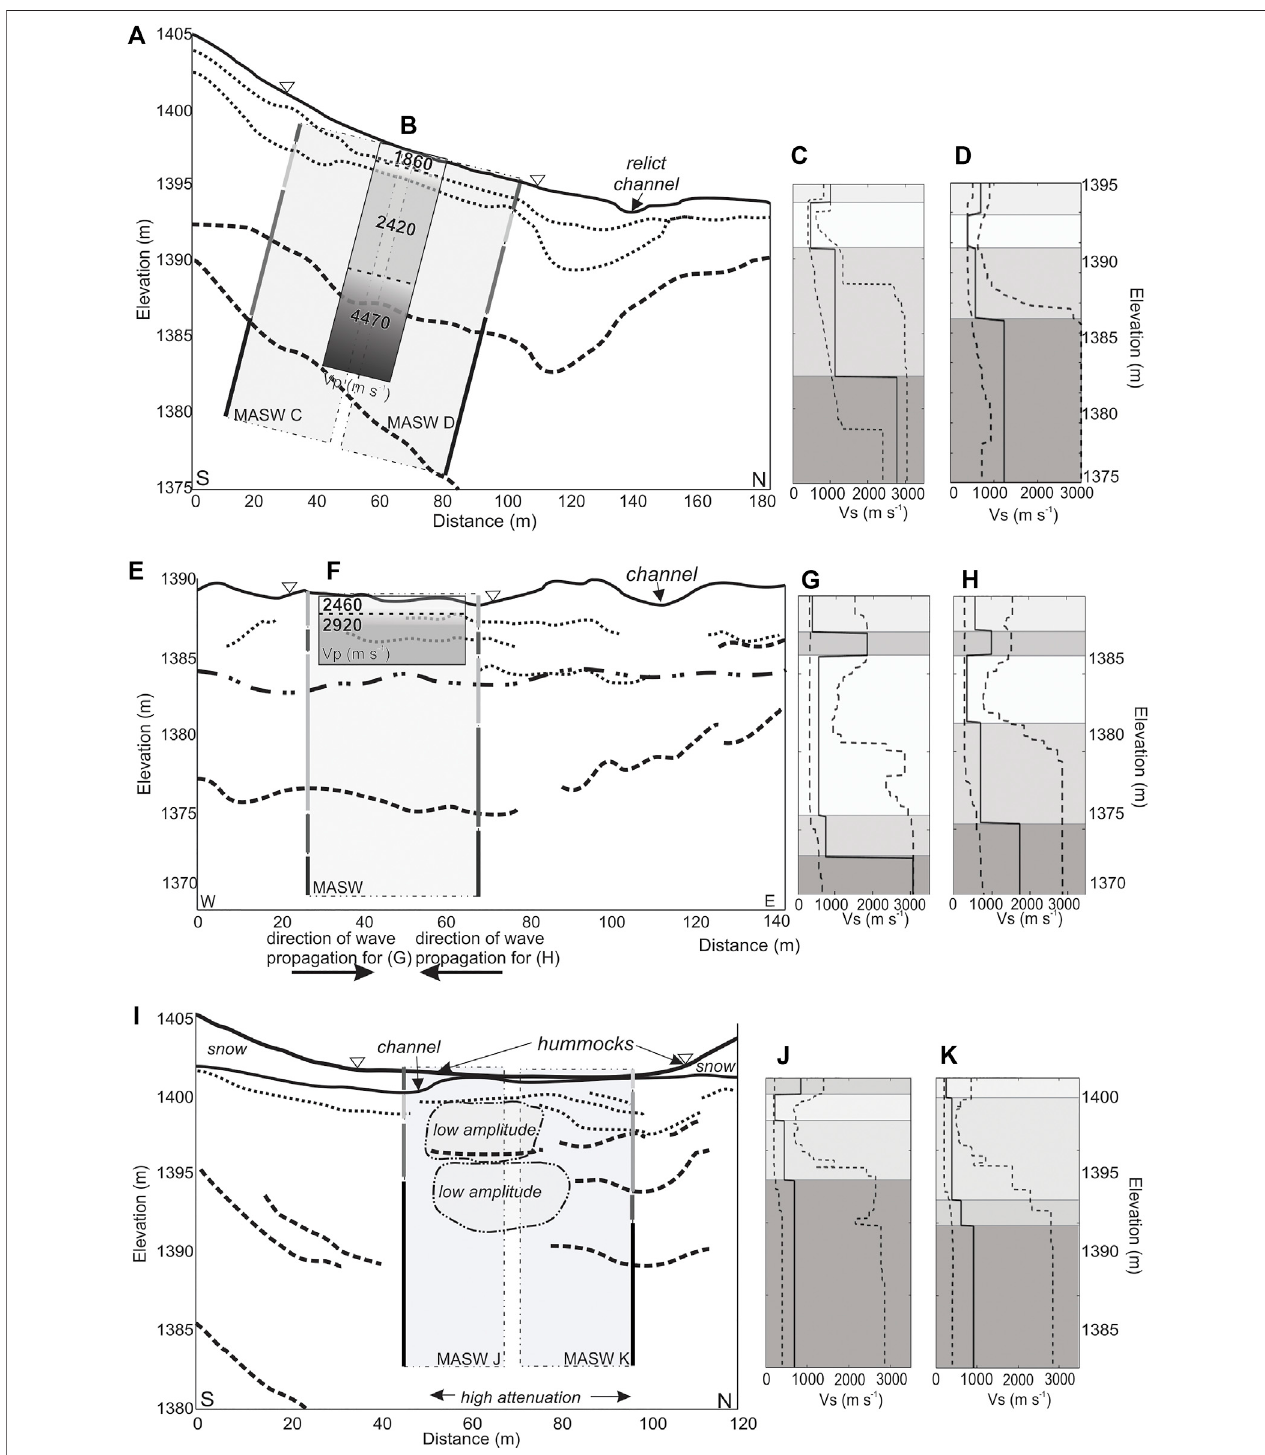
FIGURE 11 | Summary diagrams of the subsurface conditions beneath the seismic spread locations at the Lateral Moraine Site (A – D) , the Terminal Moraine Site (E – H) ,and the Hummocky Site (I – K) .(A), (E) &(I) Key features identi fi edfrom GPRradargrams. Dotted lines depict dominantre fl ections from 100 MHz pro fi les ( Figures 4B , 6B , 9B ),dashedlinesfrom25 MHzpro fi les( Figures4D , 6D , 9D ),dot-dashedlinesindicateastrongchangeinradargramcharacter,andthesolidlinesdelineatethe surface topography. Grey boxes show approximate areas over which MASW was performed with grey line segments corresponding to shading in respective MASW plots (C, D; G, H & J,K). (B) & (F)Seismic refraction results at the Lateral Moraine Site and Terminal Moraine Site, respectively,positioned at centre ofseismic line location. (C), (D), (G), (H), (J) & (K) The v s models with the lowest mis fi t (solid line) and error bounds displayed as solutions with a 10% fi t to the data (dashed lines) from MASWanalysisovertheareasde fi nedinA,E,andI.Greyshadingshowsidenti fi edlayers;darkerrepresentshighervelocity.Smalltrianglesshowendsofseismicspread